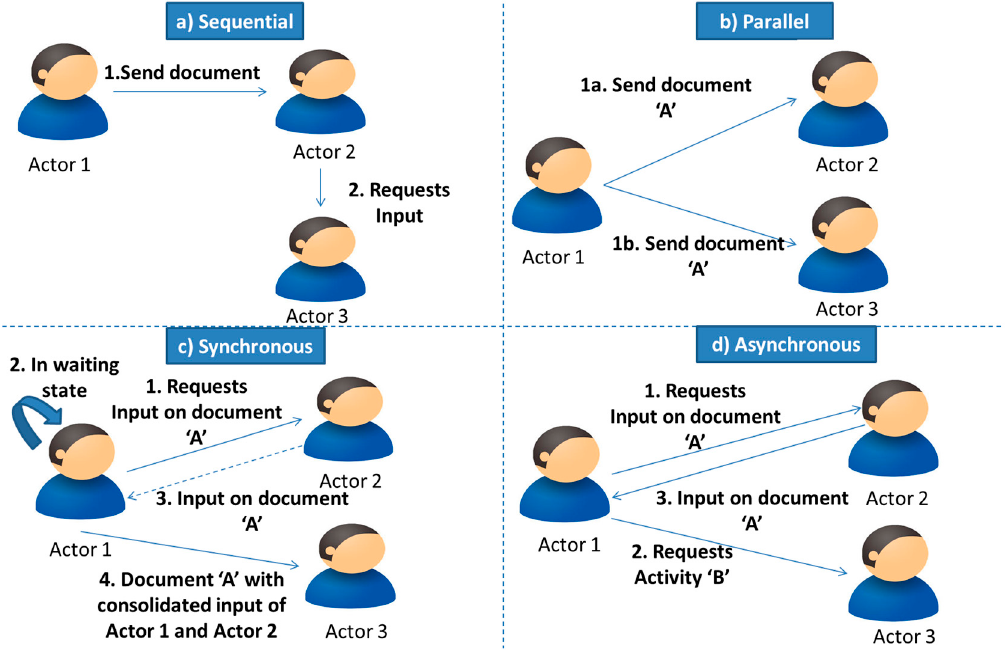
Figure 11. Communication Patterns.